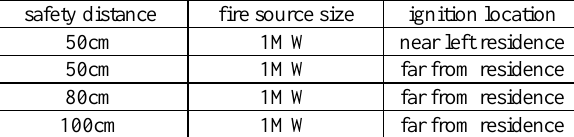
Table3. Differently safety distance and fire source size in simu- lation.